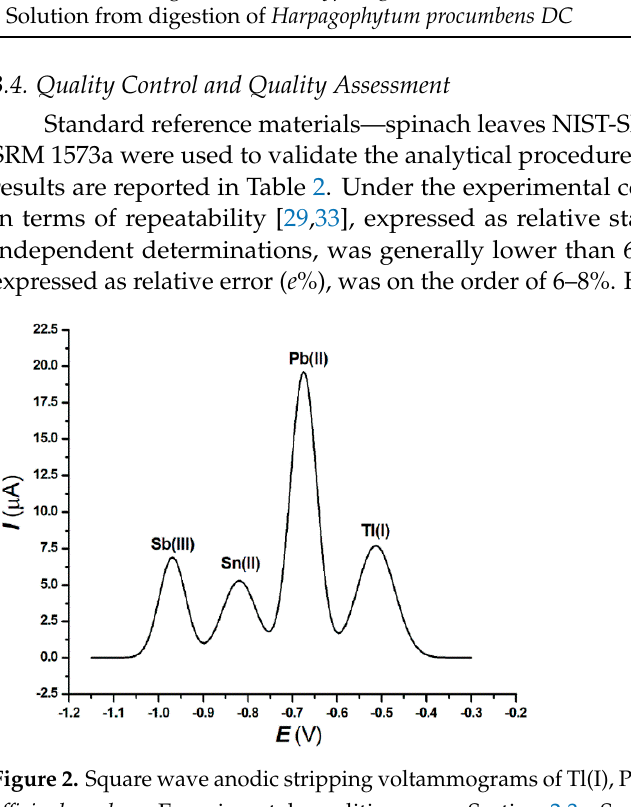
Table 3. Mean values of Tl(I) (µg kg − 1 ) for Taraxacum officinale weber, Eucalyptus globulus and Harpago- phytum procumbens DC sold on the market (Portomaggiore, Italy). The determined values are the mean of five independent determinations. Confidence level: 95%.